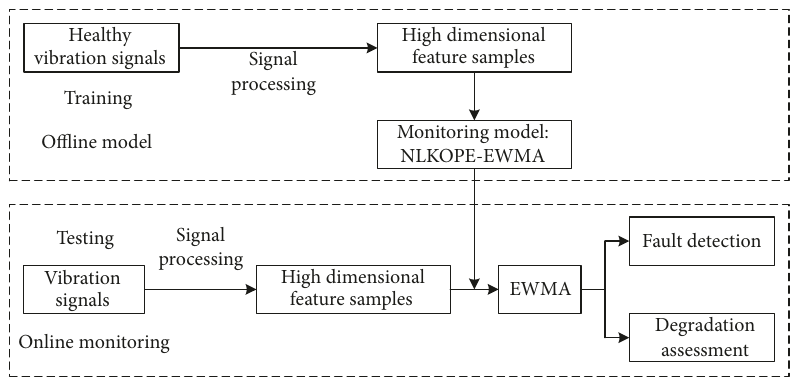
Figure 1: Procedure of condition monitoring and fault detection.